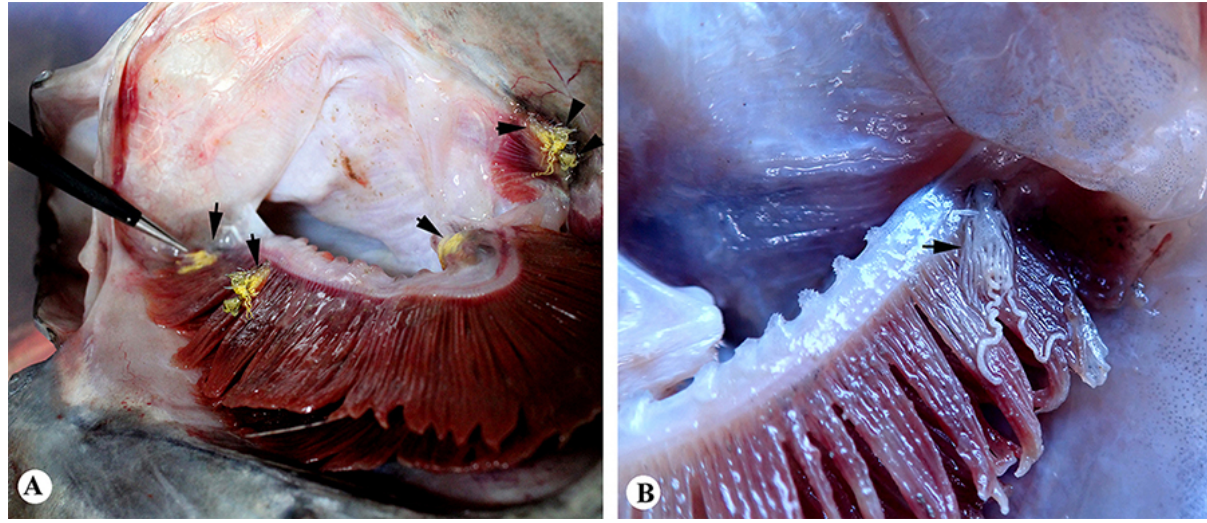
Figure 7. A , B . Site of attachment of Chondracanthus kabatai sp. n. (arrows) on its host fish Zenopsis conchifer